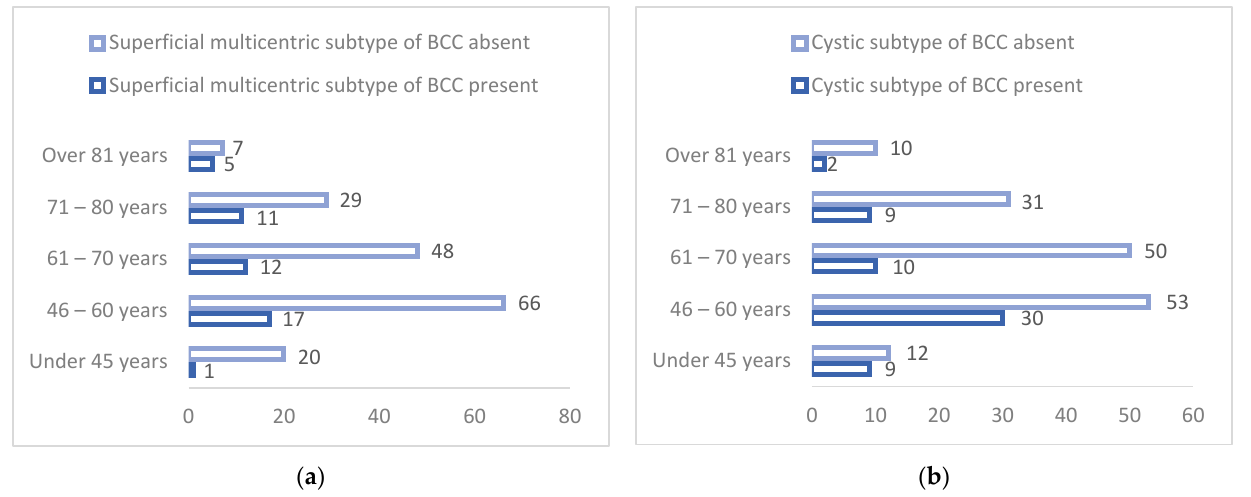
Figure 3. ( a ) Incidence of superficial multicentric BCC subtype diagnosis correlated with the age of the subject. ( b ) Incidence of cystic BCC subtype diagnosis correlated with the age of the subjects. Correlations were calculated based on the values related to the coding of each histopatho- logical BCC subtype, with 1 = absent and 2 = present.